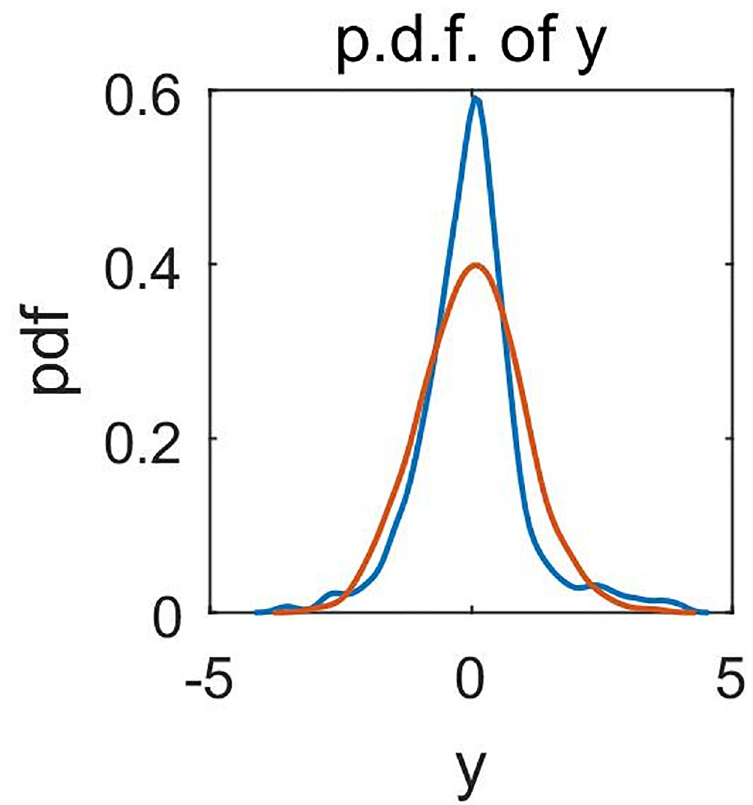
Fig 1. Probability density plots of y in the cigarette demand data set (blue line) and N (0, 1) (orange line).